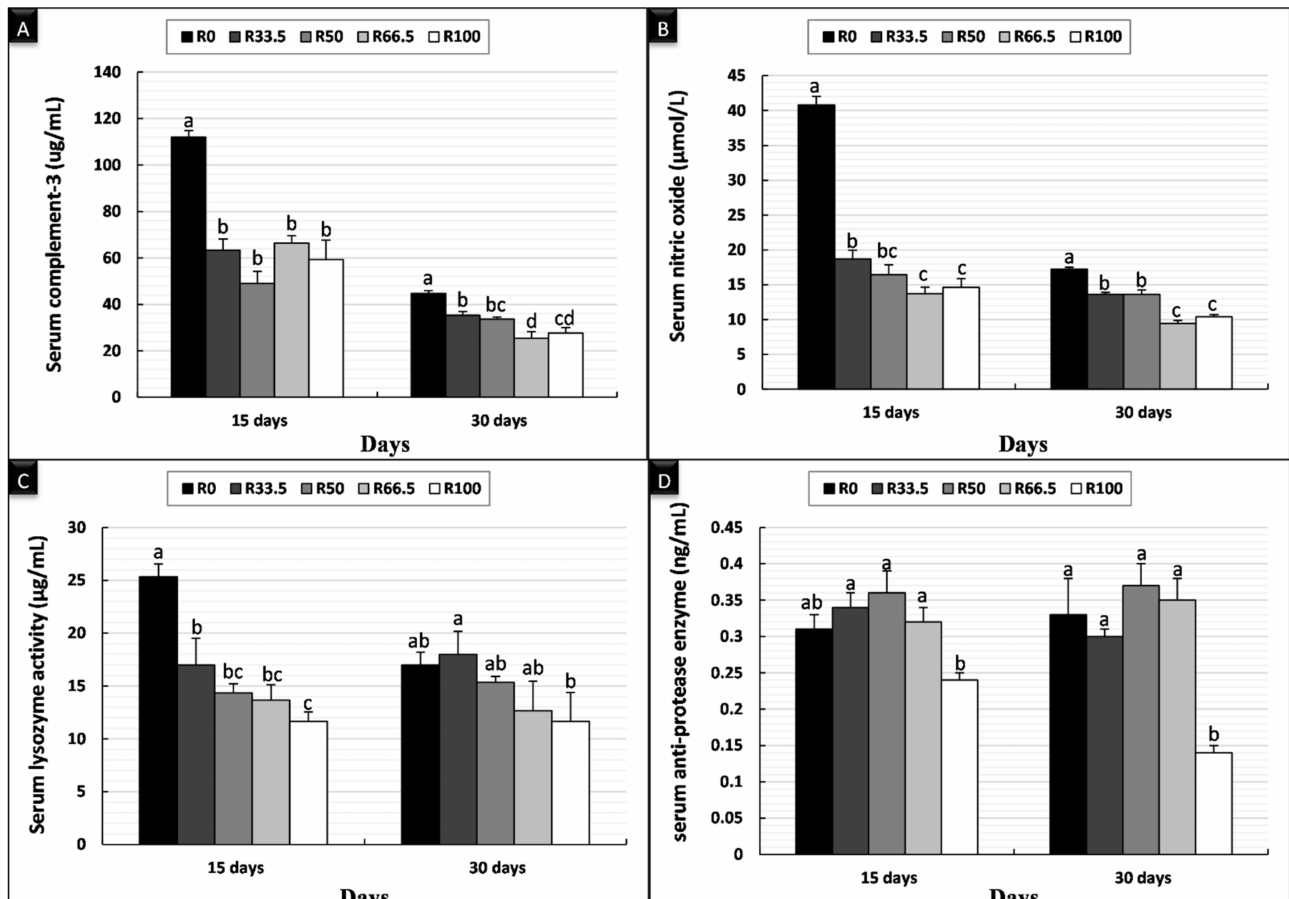
Figure 3. Nonspecific immune parameters of Clarias gariepinus (mean ± SE) fed experimental diets in which fishmeal was replaced by plant protein (soybean and sunflower meal) after 15 and 30 days. ( A ) Bars indicate serum complement- 3 ( µ g/mL). ( B ) Bars indicate serum nitric oxide ( µ mol/L). ( C ) Bars indicate serum lysozyme activity ( µ g/mL). ( D ) Bars indicate serum anti-protease enzyme (ng/mL). Groups with different superscripts (a, b and c) were significantly different ( p < 0.05, using one-way ANOVA to detect the difference among groups within the same period). R0, R33.5, R50, R66.5 and R100: see legend of Figure